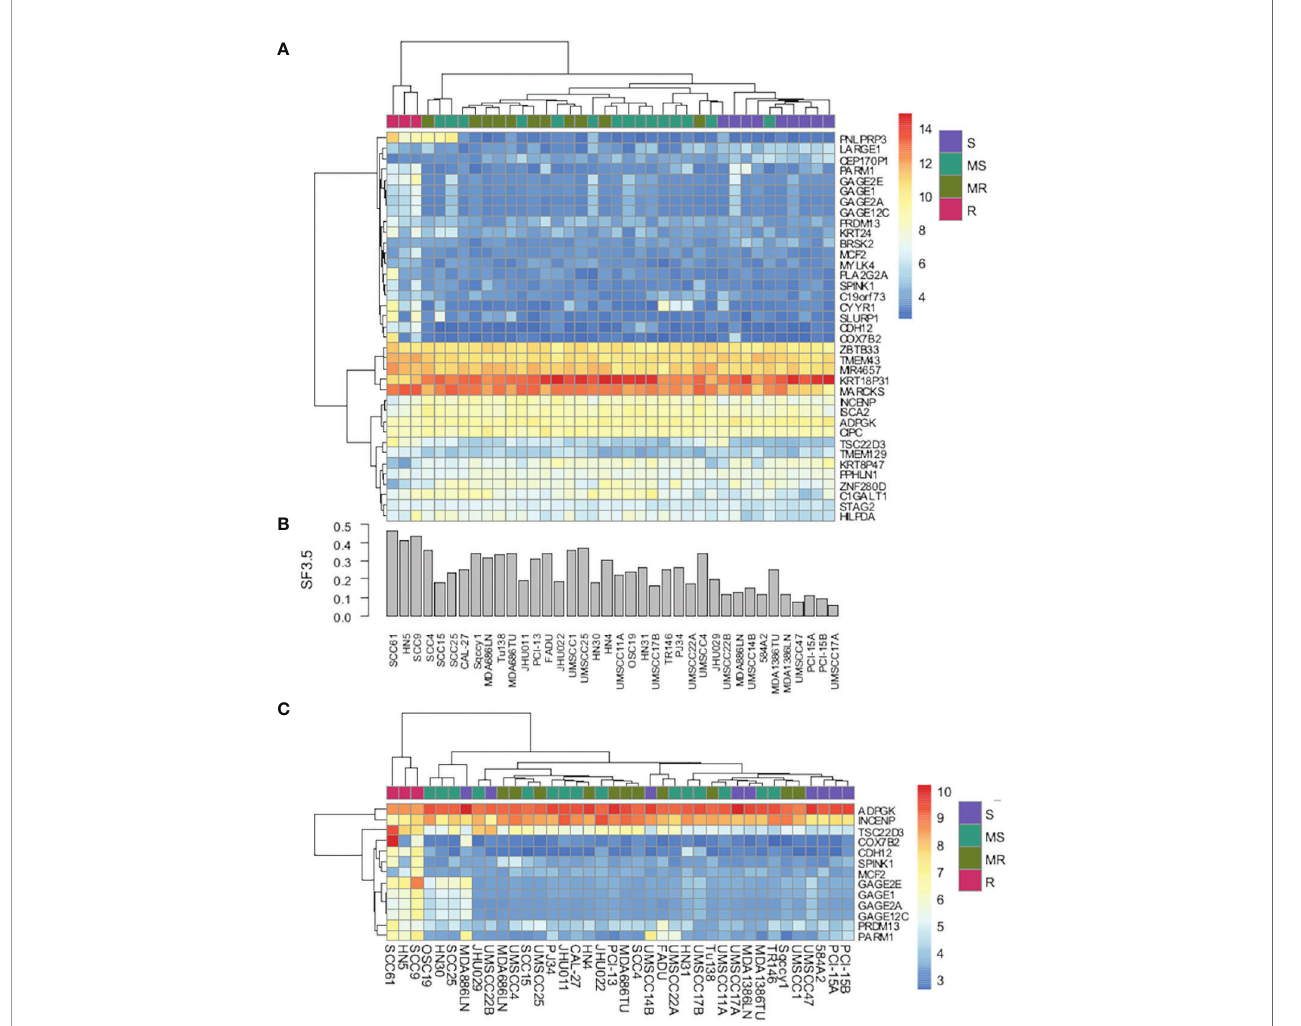
FIGURE 2 | (A) Heat map of gene expression using a 37-gene signature that segregates cell lines by radiosensitivity cluster. (B) Bar chart of radiosensitivity (SF3.5) for each cell line. (C) Heat map of gene expression using a 13-gene signature that segregates radioresistant cells from all other cell